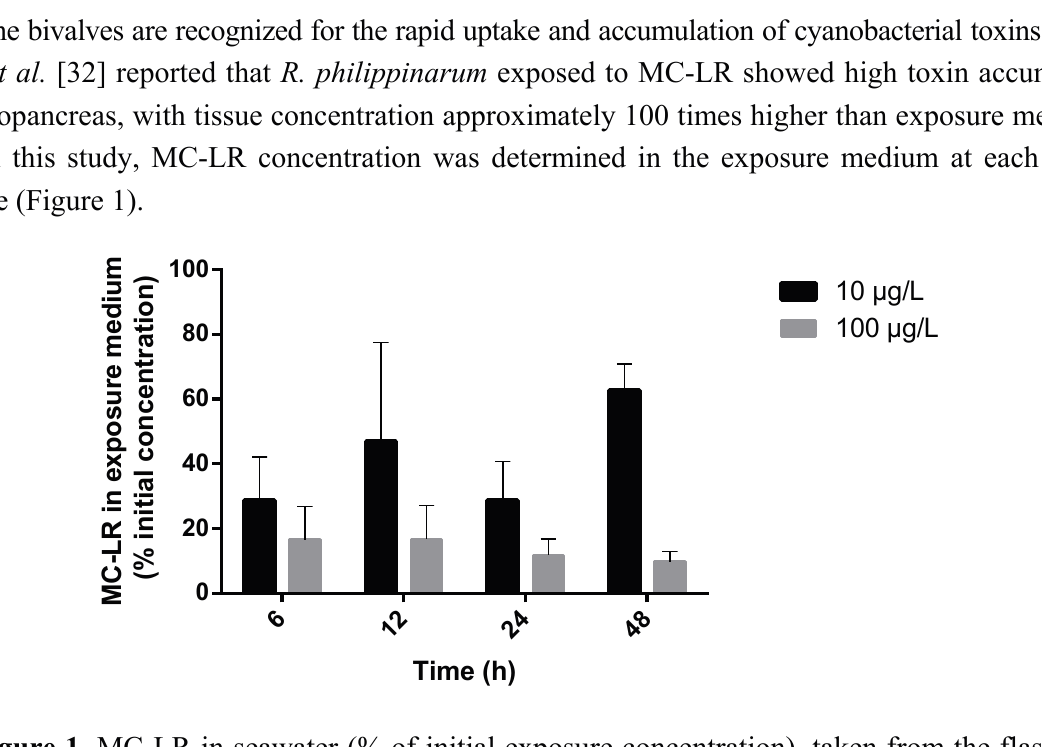
Figure 1. MC-LR in seawater (% of initial exposure concentration), taken from the flasks where the animals were exposed at the end of each experimental period. Black columns represent low-exposure group (10 µg/L MC-LR), light grey columns represent high-exposure group (100 µg/L MC-LR) (bars show standard